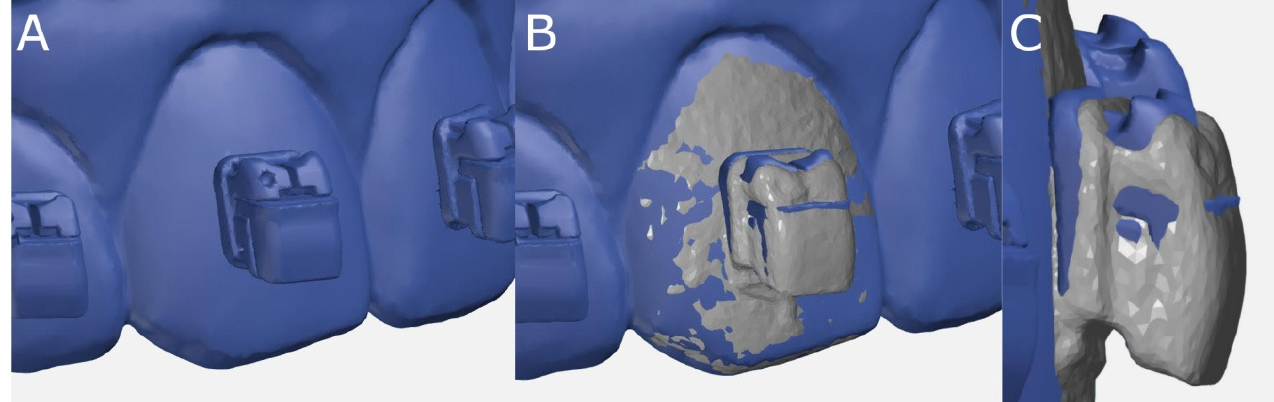
Figure 4. ( A ) The STL digital file of the fixed buccal multibracket appliances digitally planned on the experimental anatomically based models. ( B ) Front and ( C ) right lateral views of the alignment procedure of the STL digital file from the virtually planned position of the digitalized fixed buccal multibracket appliances and the STL digital file from the digital impression of the fixed buccal multibracket appliances bonded to the experimental anatomically based models.